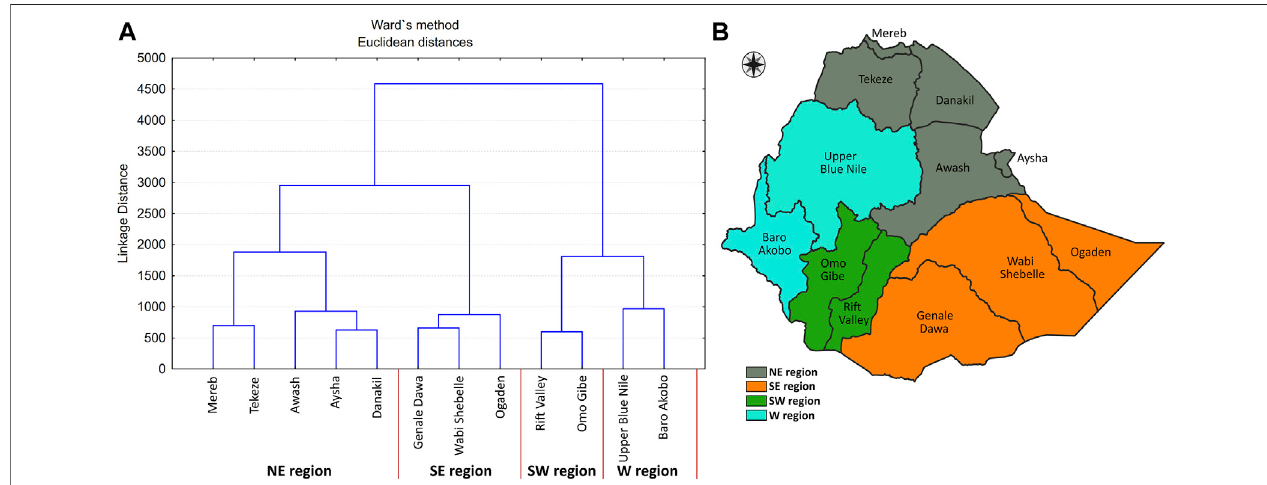
FIGURE 2 | (A) Graphical illustration of Ward ’ s method: tree diagram showing the assigned clusters, and (B) schematic representation of the clusters, named as: northeast (NE), southeast (SE), southwest (SW), and west (W).